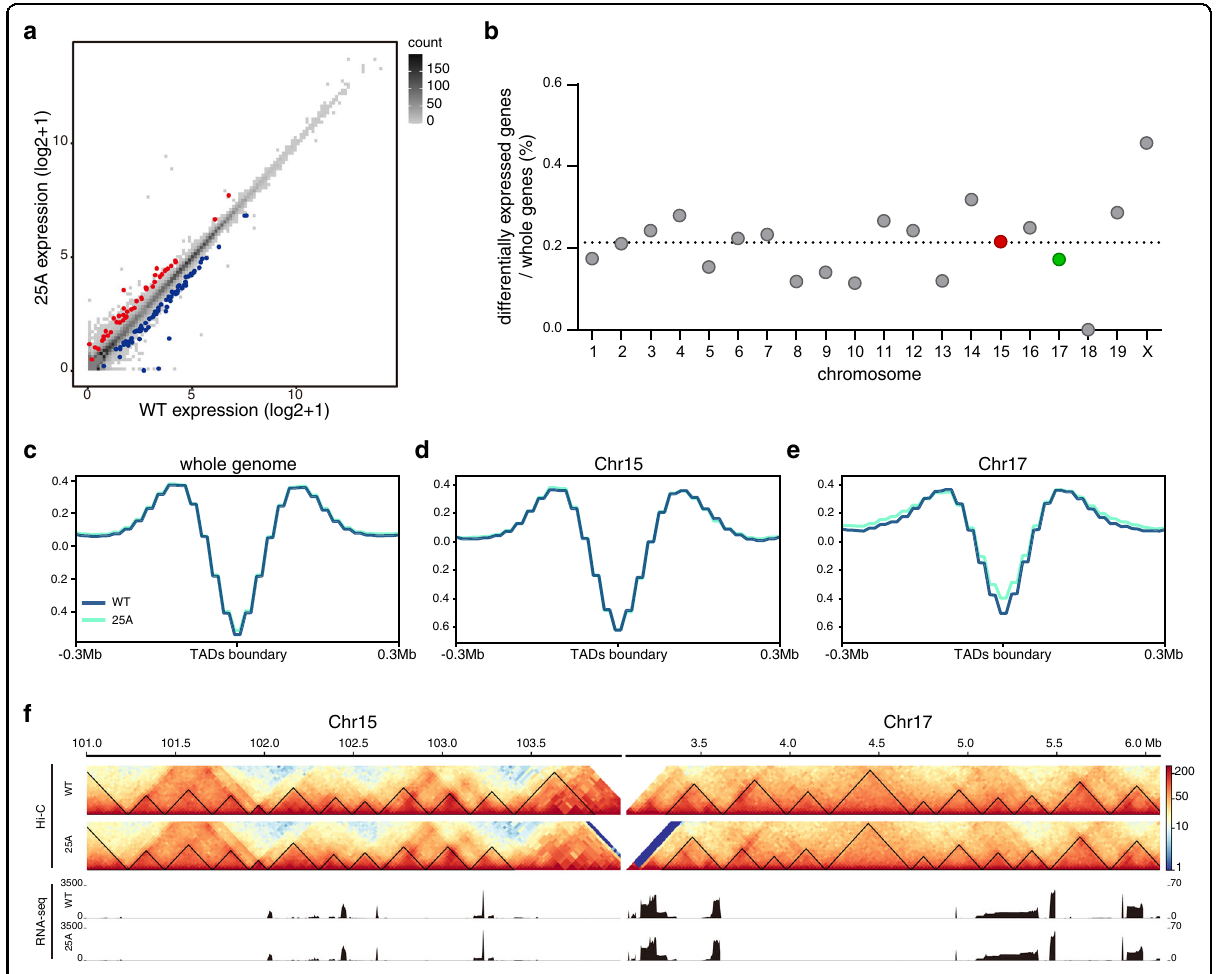
Fig. 3 Transcriptome and TADs analyses in 25A cells. a Comparison of gene expression in 25A cells and WT cells. Upregulated and downregulated genes were shown in red and blue, respectively (FDR < 5%). b The proportion of the differentially expressed genes in each chromosome of 25A cells. The dash line indicates the average proportion of differentially expressed genes of the whole genome. c – e Comparison of TAD boundaries in WT and 25A cells. Aggregate pro fi les of insulation scores around TADs boundaries at a 10 Kb resolution for the whole genome ( c ), Chr15 ( d ) and Chr17 ( e ). f Hi-C contact matrixes of the 3 Mb region upstream from chromosome fusion site on Chr15 and downstream on Chr17 of WT and 25A cells. TADs are depicted as black triangles. RNA-seq expression tracks in the corresponding fusion regions in both WT and 25A cells are shown in lower